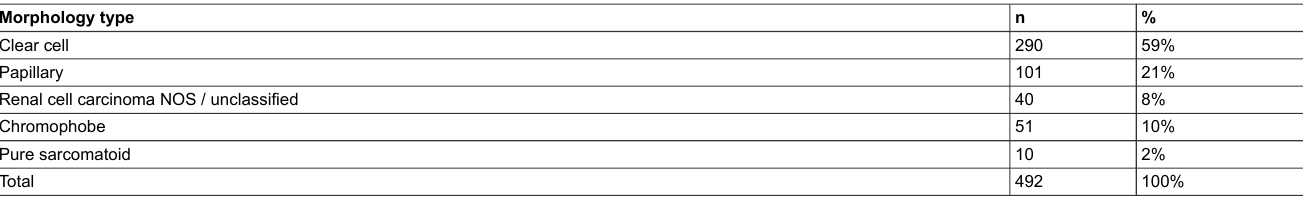
Table 2: Distribution of patients without metastases by type of nephrectomy and place of treatment, p = 0.029. Type of